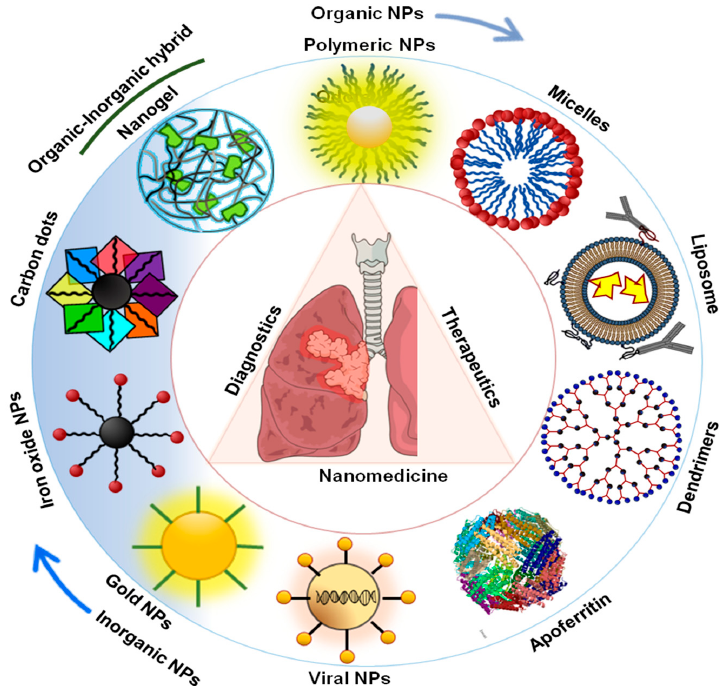
Figure 1. Schematic representation of di ff erent theranostics nanomedicine approaches in lung cancer theranostics.